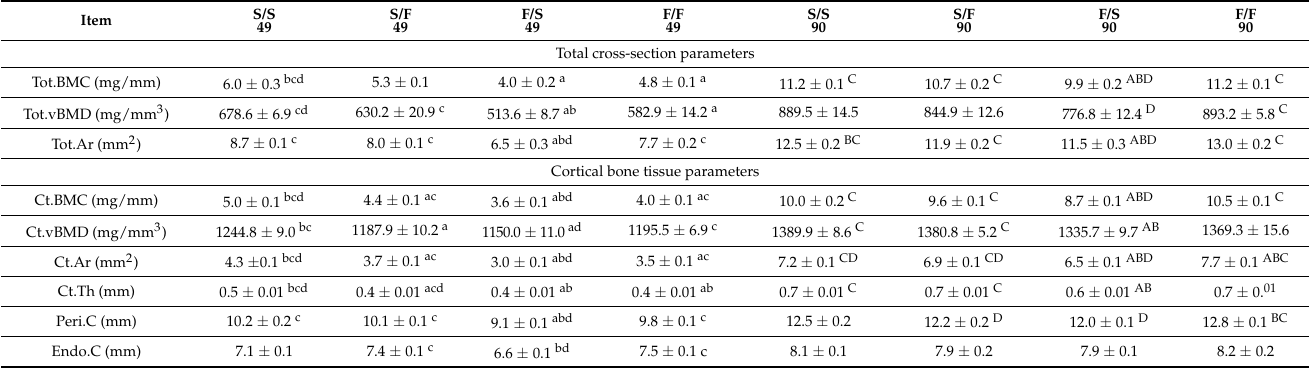
Table 4. Tomographic (pQCT) parameters of the femur in the midshaft diaphysis.